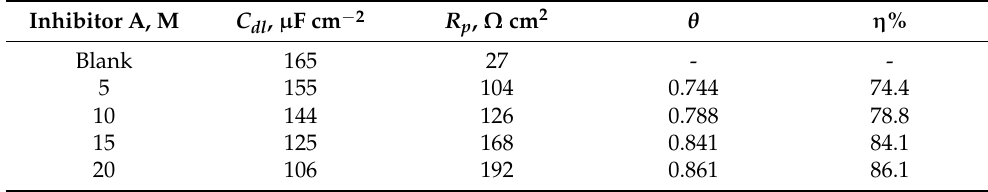
Table 7. Data for the corrosion of Cu in 1.0 M HNO 3 solution in in the absence and presence of numerous doses of ACR-2 from the EIS.